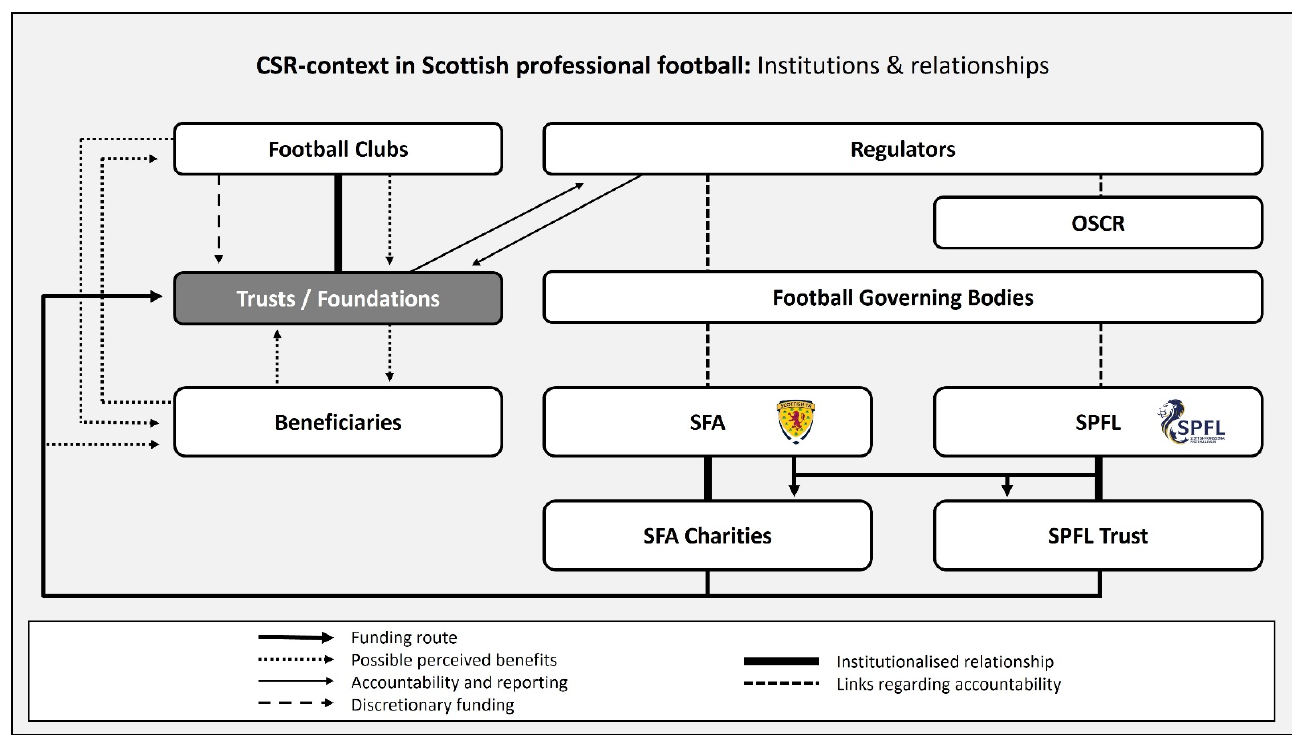
Figure 3. Contextual relationships (adapted from Anagnostopoulos et al. 2014, p. 262).